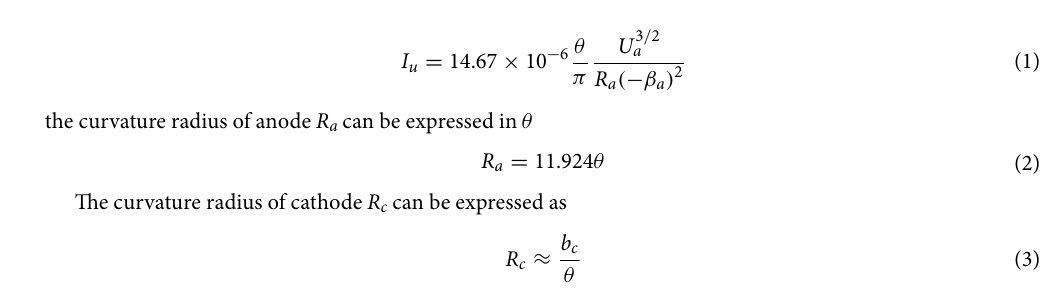
The curvature radius of cathode R c can be expressed as